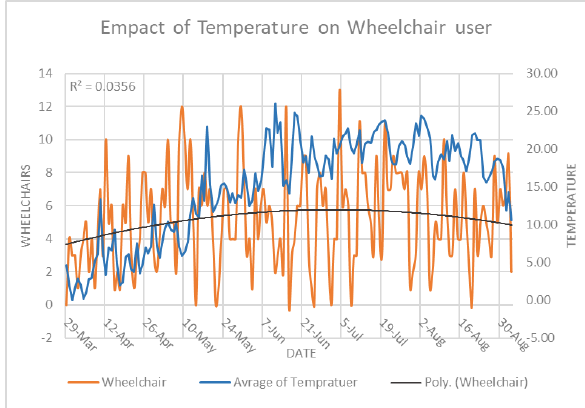
Chart 1. Relation of temperature and presence of wheelchair users